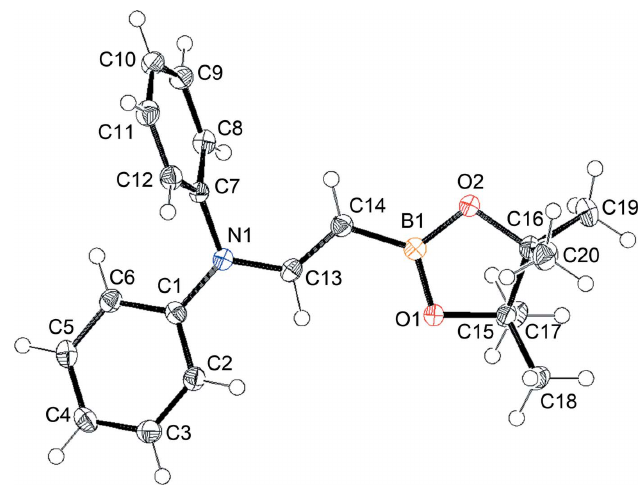
Figure 1 The molecular structure of the title compound with displacement ellipsoids drawn at the 50% probability level; H are atoms shown as small